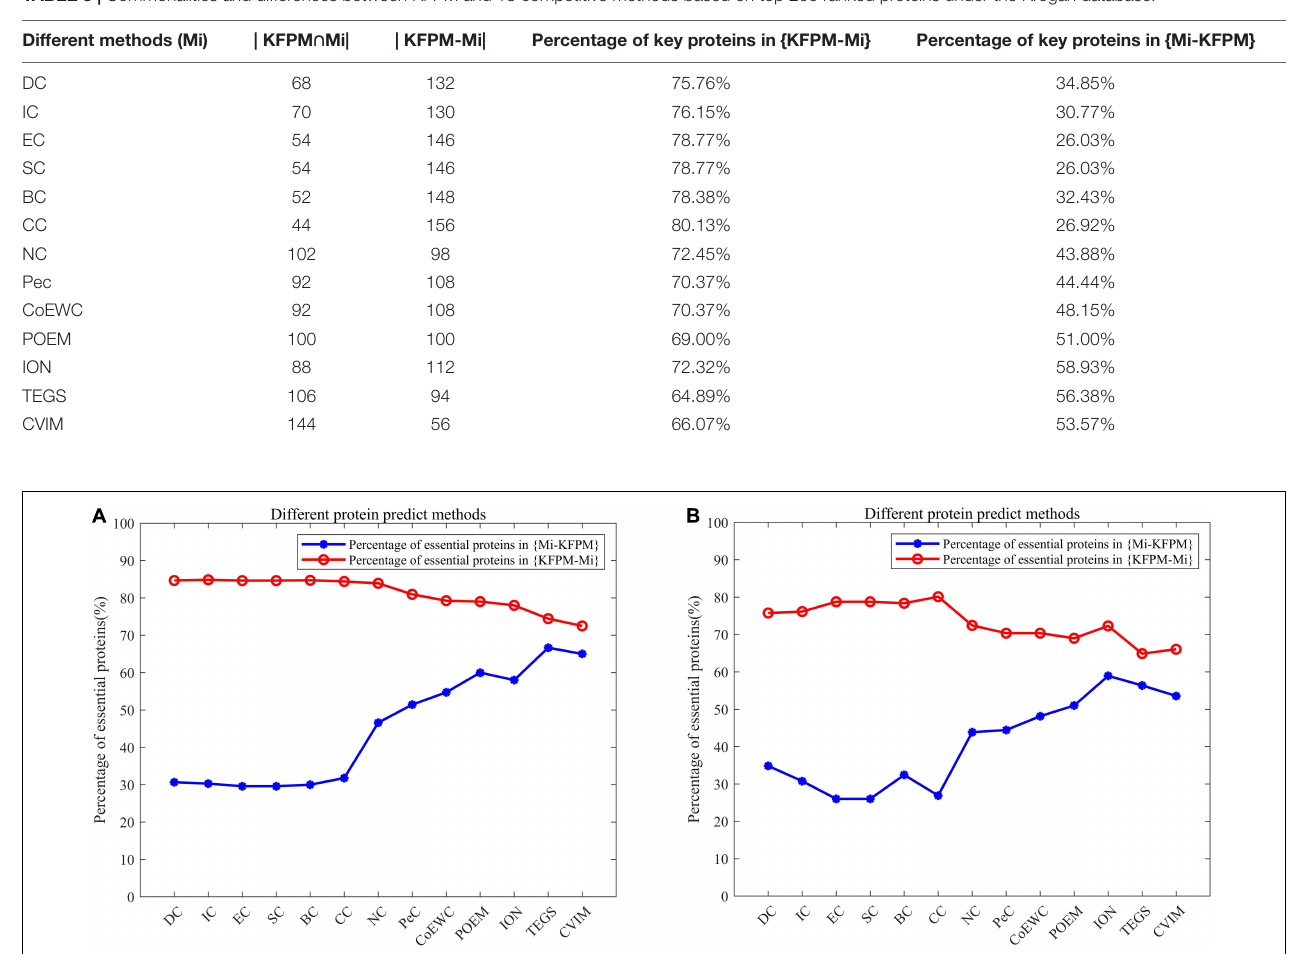
FIGURE 6 | Intuitive comparison of predictive performance between KFPM and 13 competitive methods. The X -axis represents 13 methods. The Y -axis denotes the percentage of essential proteins in { KFPM − Mi } or { Mi − KFPM } .